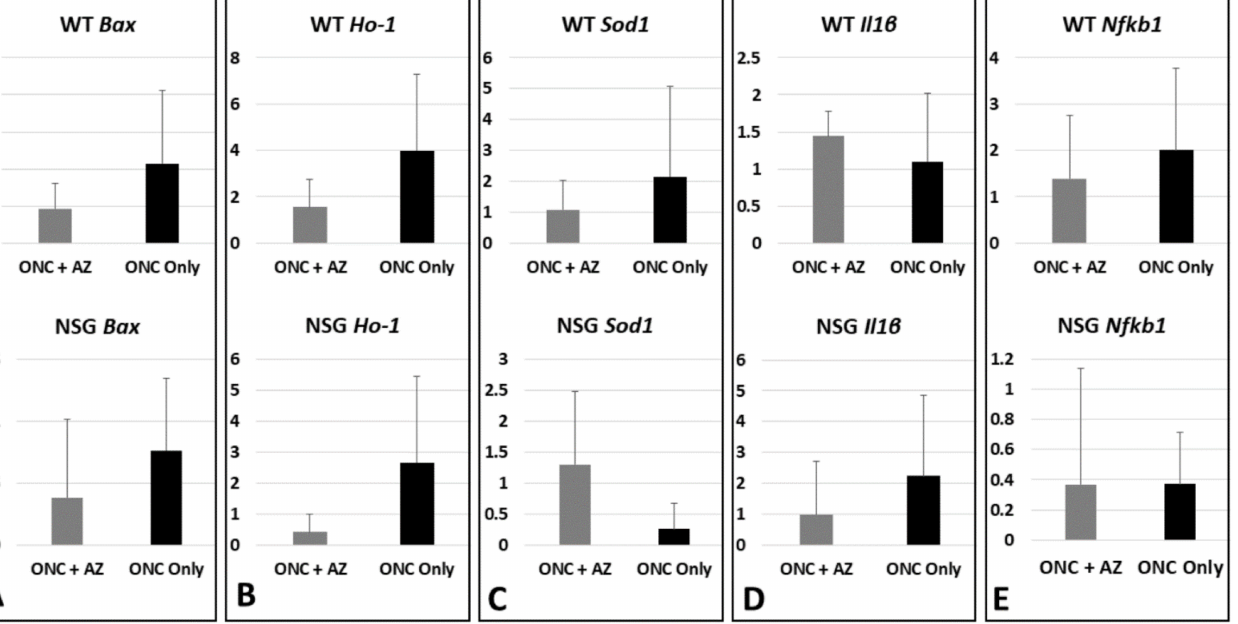
Figure 5. Molecular analysis of the retinas, day 3 after ONC. ( A ) Bax expression levels in WT mice increased without treatment and decreased with AZ treatment, while in NSG mice levels remained at baseline without treatment and decreased with AZ treatment. ( B ) Ho-1 levels in both WT and NSG mice increased without treatment and decreased with AZ treatment. ( C ) Sod1 levels in WT mice increased without treatment and decreased with AZ treatment, while levels in NSG mice decreased without treatment and increased with AZ treatment. ( D ) Il1 β levels in WT mice slightly increased without and with treatment, while in NSG mice levels increased without treatment and decreased with AZ treatment. ( E ) Nfkb1 levels in WT mice increased without treatment and decreased with AZ treatment, while in NSG mice levels decreased without and with